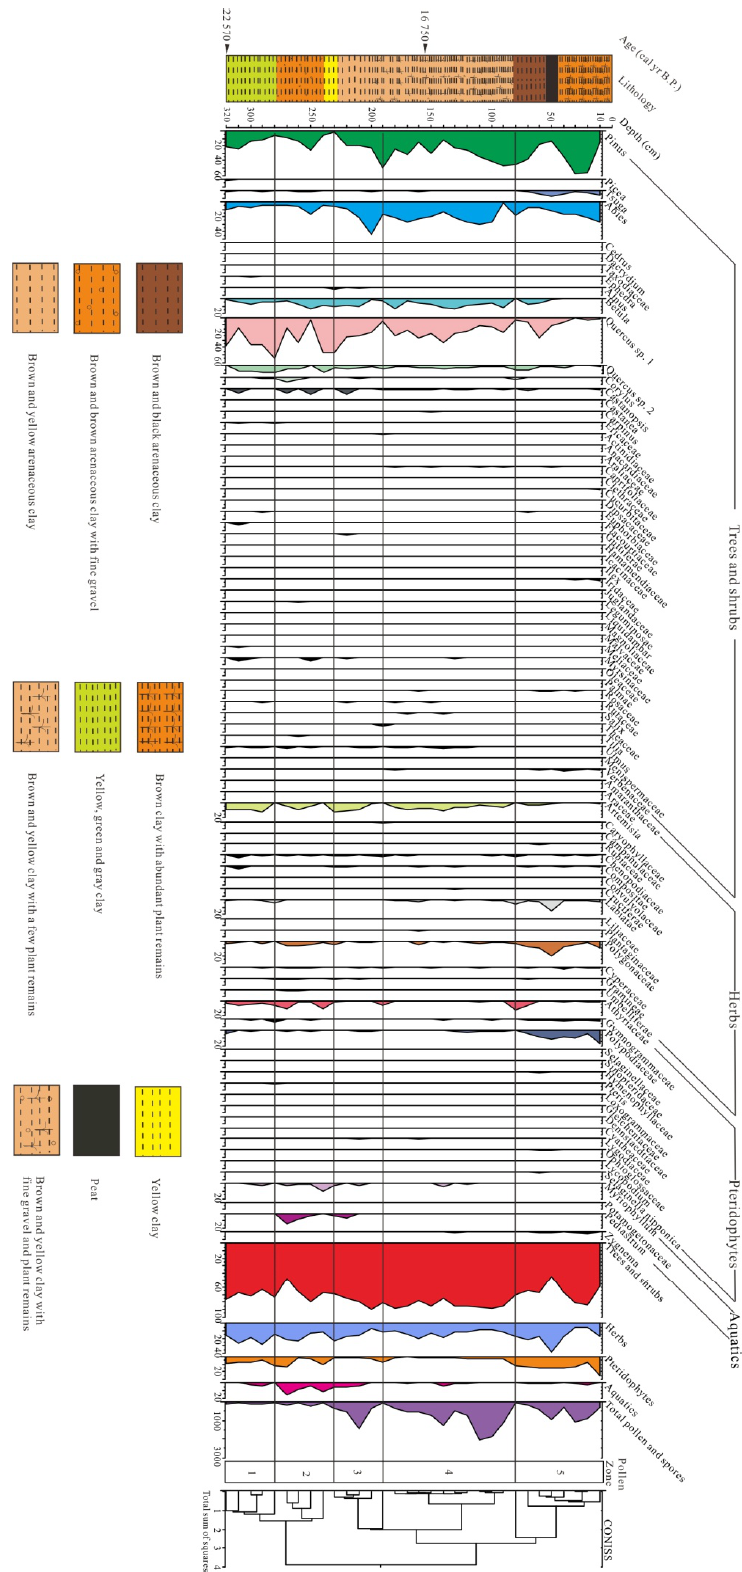
Figure 2. Pollen percentage diagram from Wenhai Lake, northwestern Yunnan,